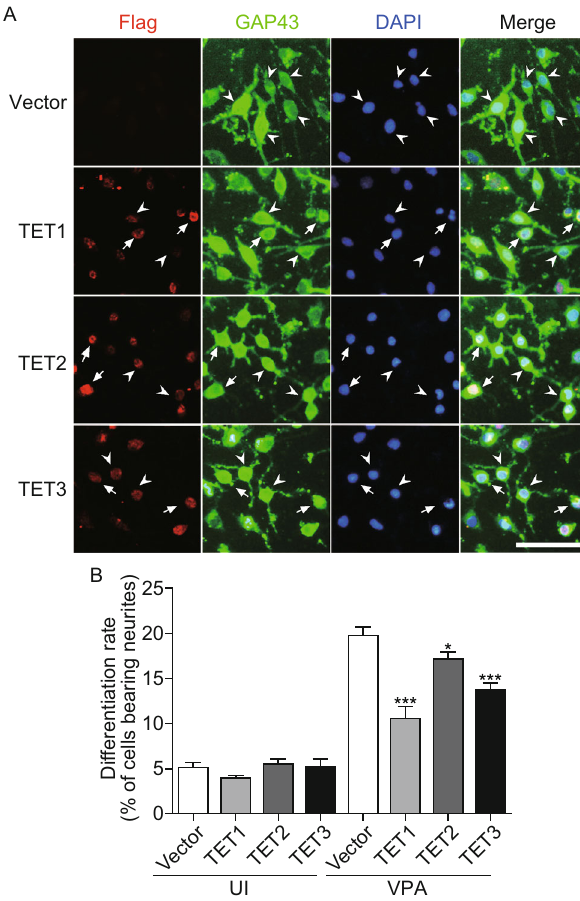
Figure 3. Overexpression of TET proteins inhibits VPA- induced neuronal differentiation of Neuro2a cells. (A) Neuro2a cells transfected with control vector (Vector) or vector harboring TET1, TET2, or TET3 gene were co- immunostained with Flag and GAP43 antibodies. Arrow- heads indicate the differentiated cells and arrows indicate the undifferentiated cells. Scale bar = 100 μ m. (B) Quan- ti fi cations of the differentiation rates from Neuro2a cells in the absence (UI) or presence of VPA stimulation (VPA) for 24 h. Values are mean ± SEM, * P < 0.05, *** P